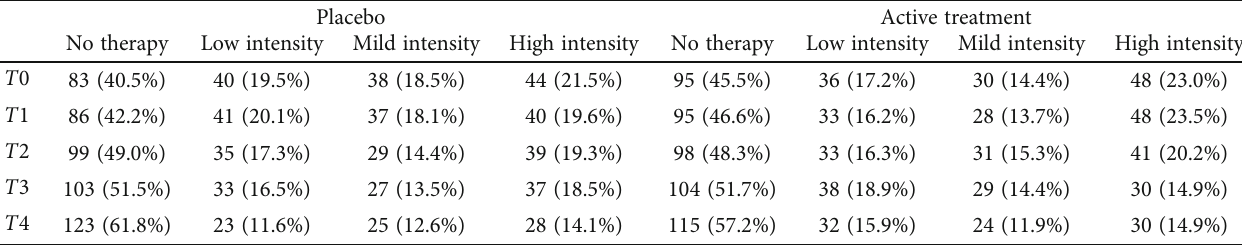
Table 4: Maintenance therapy over time: intensity of asthma treatment in both groups.